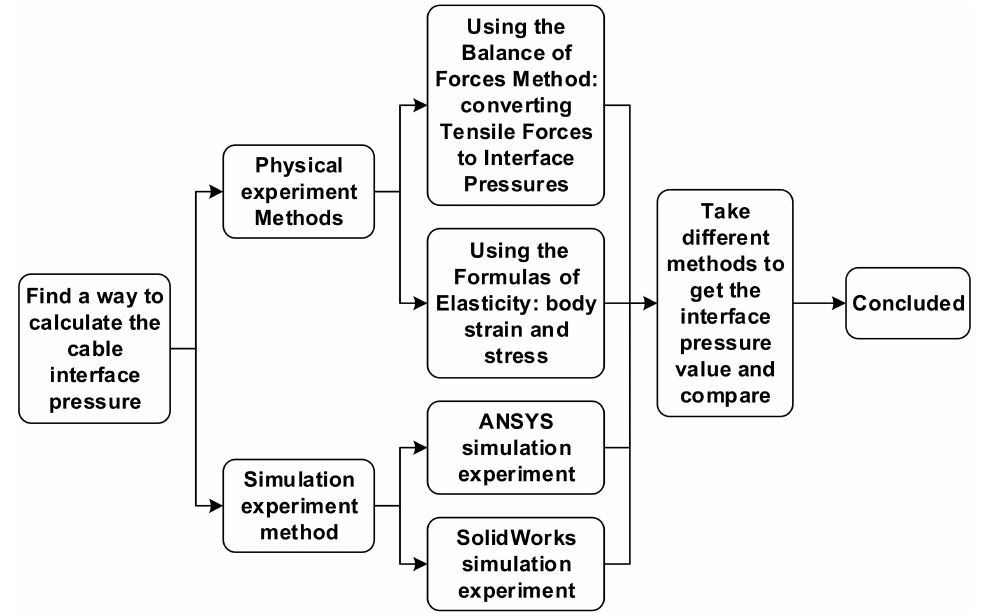
Figure 1. Study flowchart.